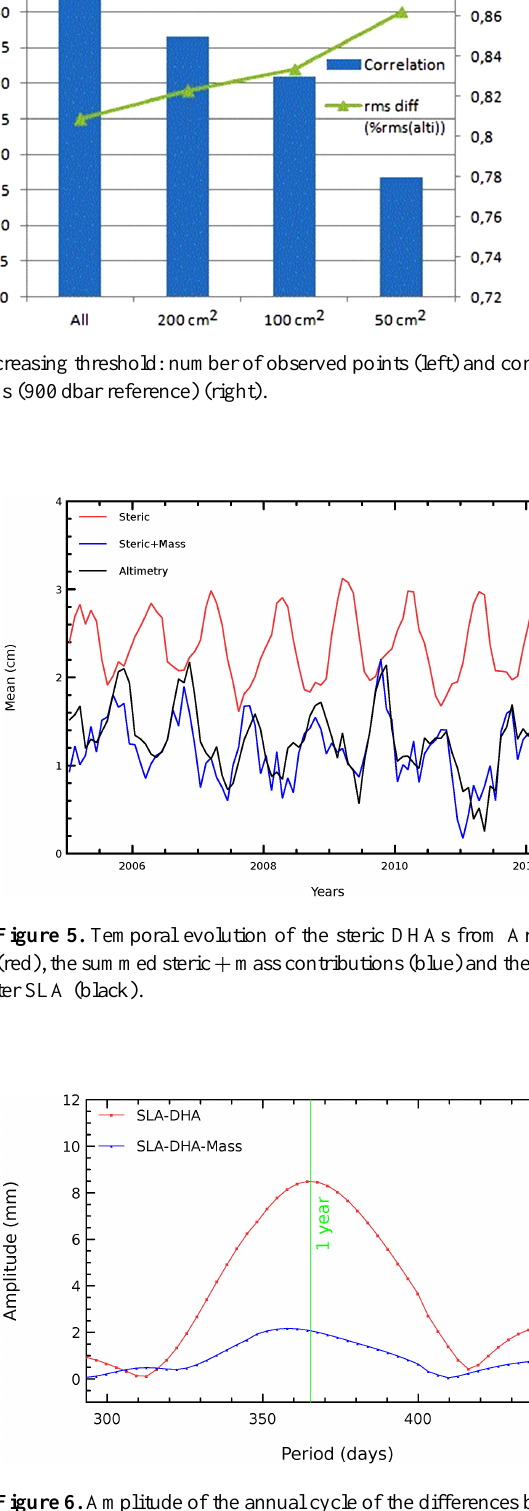
Figure 6. Amplitude of the annual cycle of the differences between Jason-1 altimeter SLAs and Argo DHAs only (red) or between SLAs and DHAs + ocean mass (GRACE GRGS V3) (in